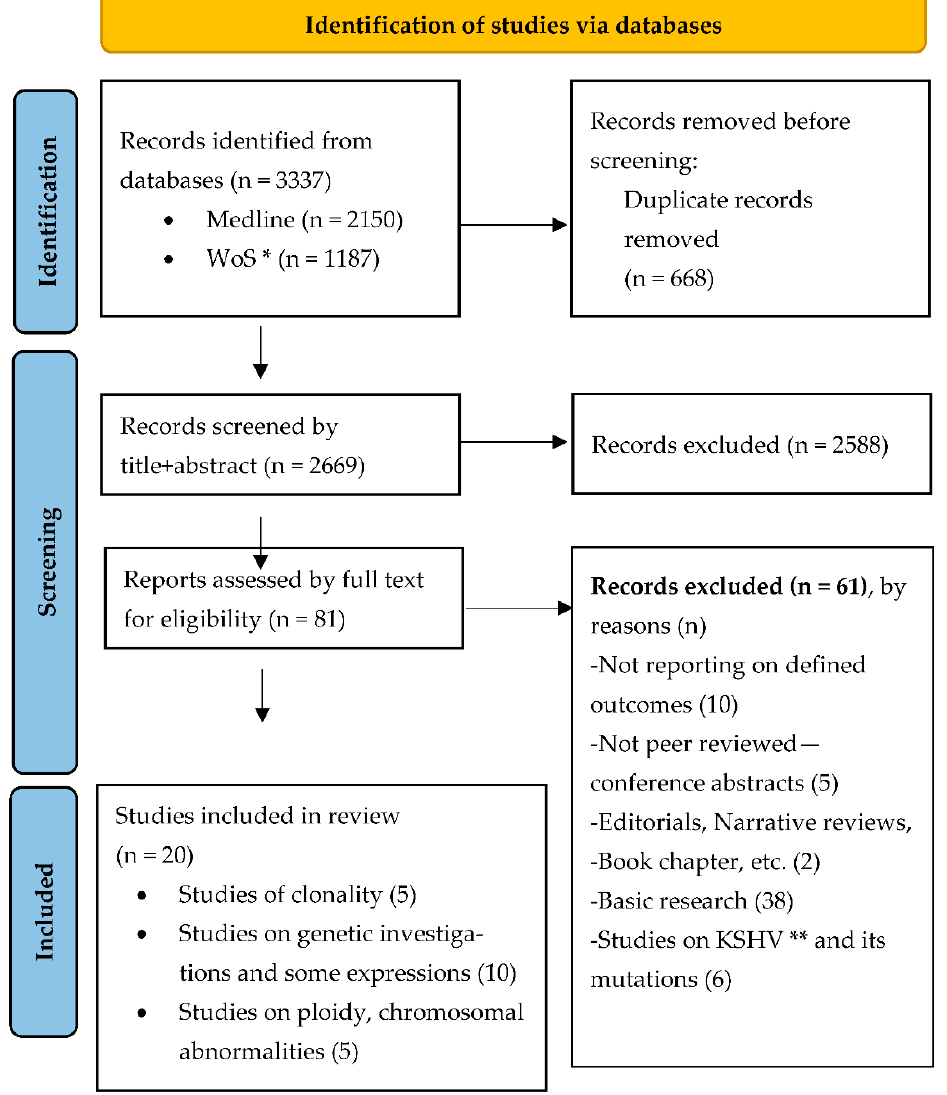
Figure 1. PRISMA 2020 flow diagram [19] for systematic review on clonality and mutation in Kaposi sarcoma. * Web of Science, ** Kaposi Sarcoma related Herpes Virus research. Copyright statement: this PRISMA diagram contains public sector information licensed under the Open Government Licence v3.0. Adapted From: Moher D, Liberati A, Tetzlaff J, Altman DG, PLOS Medicine (OPEN ACCESS) Page MJ, McKenzie JE, Bossuyt PM, Boutron I, Hoffmann TC, Mulrow CD, et al. The PRISMA 2020 statement: an updated guideline for reporting systematic reviews. PLOS